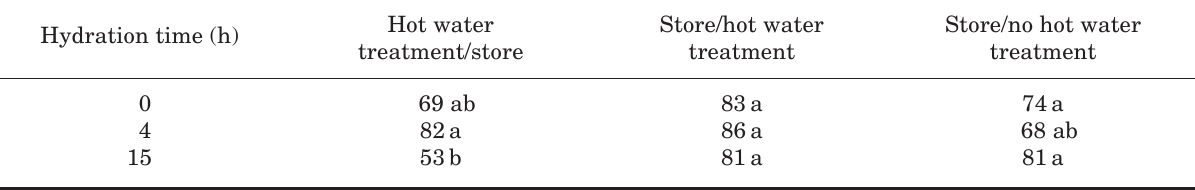
Table 1. Cultivar Chardonnay - means of callus development scores expressed as the percentage of the complete ring of callus formed at the basal circumference of each